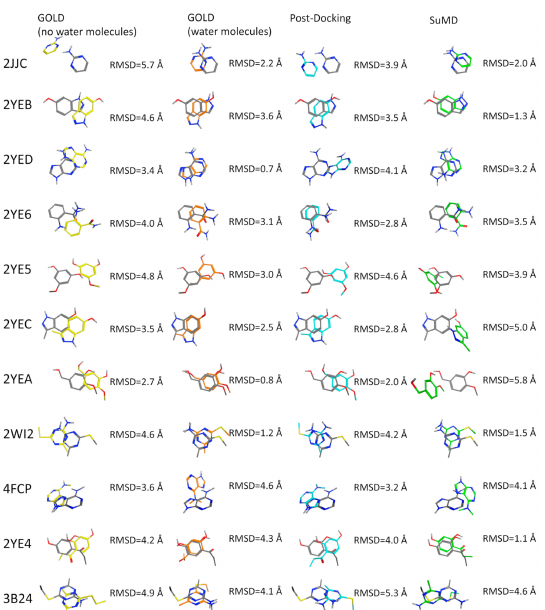
Figure 3. First pose comparison between the di ff erent methods (yellow: GOLD without water molecules. Orange: GOLD with water molecules. Blue: Post-Docking. Green: SuMD) for each fragment. In gray is reported the crystallographic pose.